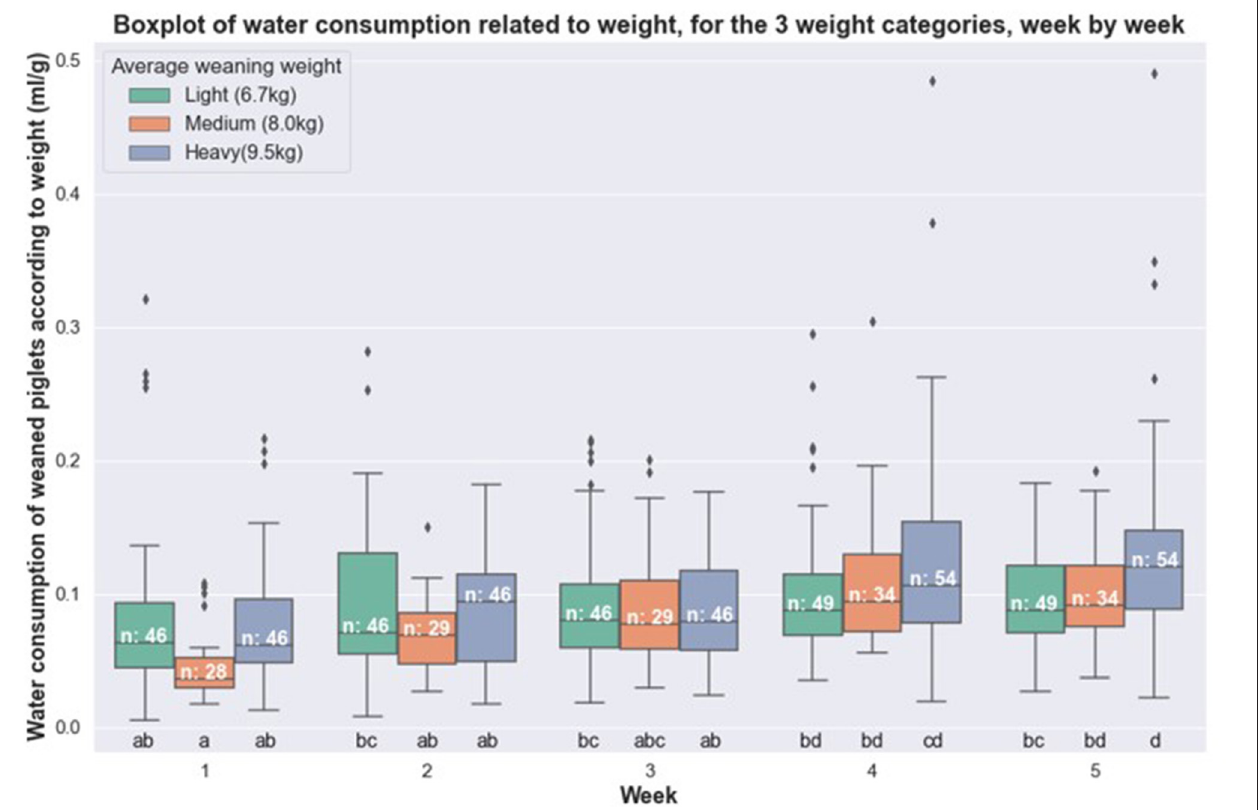
FIGURE 2 | Boxplot of water consumption related to weight for healthy piglets, week by week, according to their weight category (light, medium and